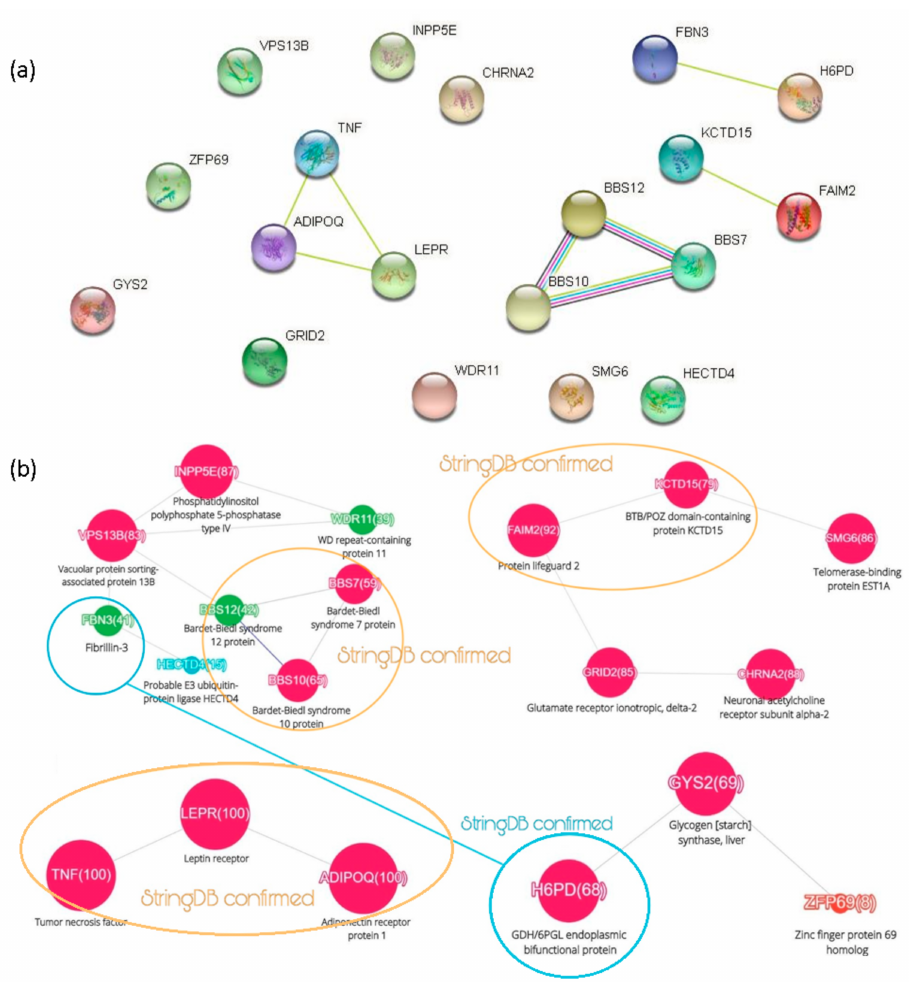
Figure 4. The relationship among the clusters as found by using STRING ( a ) with consequent reproduction of the Figure 3 with graphical illustration of the links between genes ( b